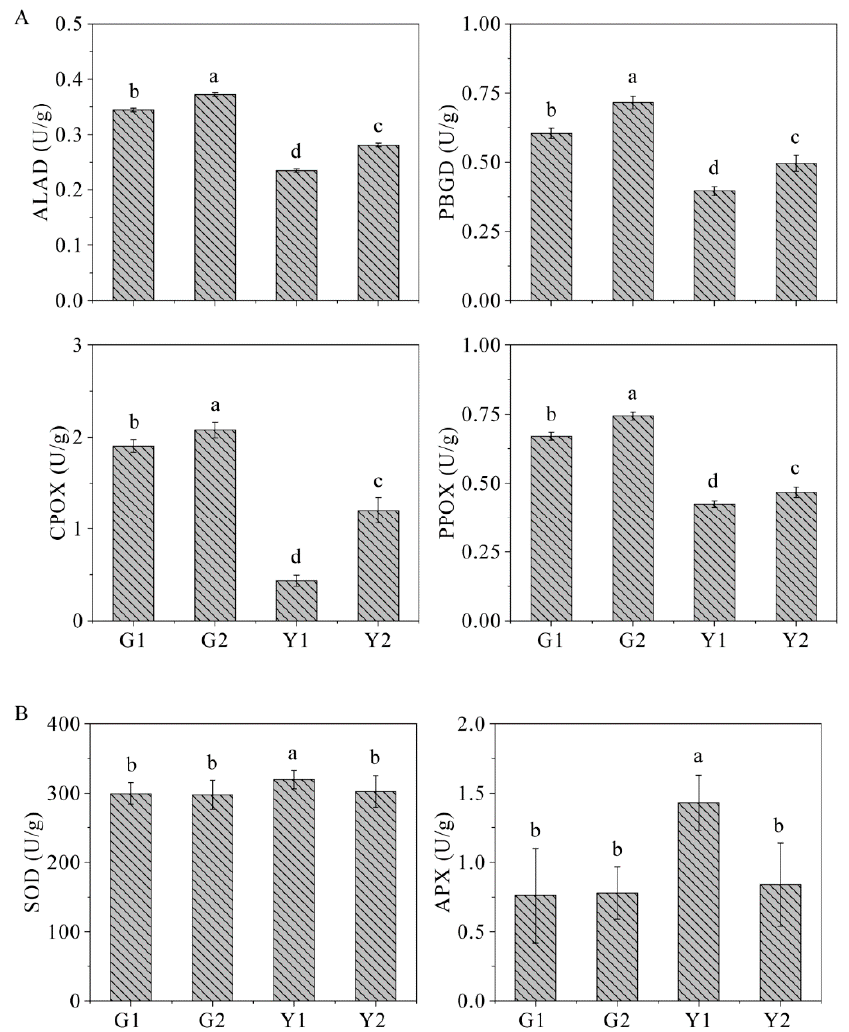
Figure 8. The key enzyme activities in chlorophyll synthesis and stress resistance. ( A ) The enzyme activities of ALA dehydrogenase (ALAD), porphobilinogen deaminase (PBGD), coproporphyrinogen III oxidase (CPOX), and protoporphyrinogen IX oxidase (PPOX); ( B ) the enzyme activities of superoxide dismutase (SOD) and ascorbate peroxidase (APX).